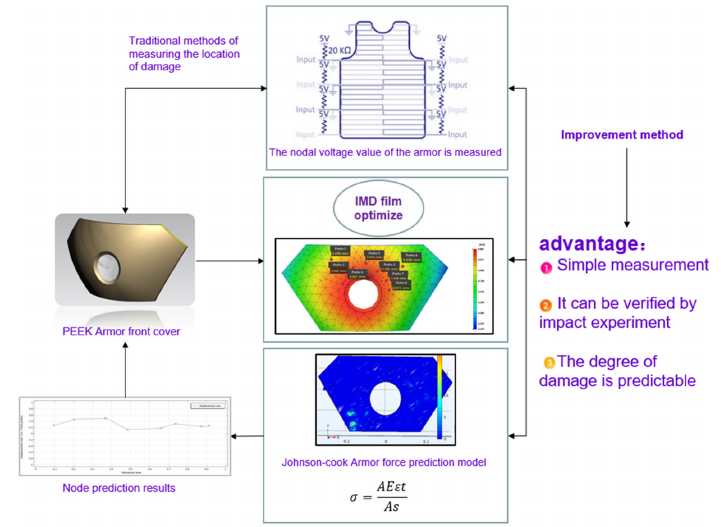
Figure 1. Thin film IMD characteristic model test steps and advantages.